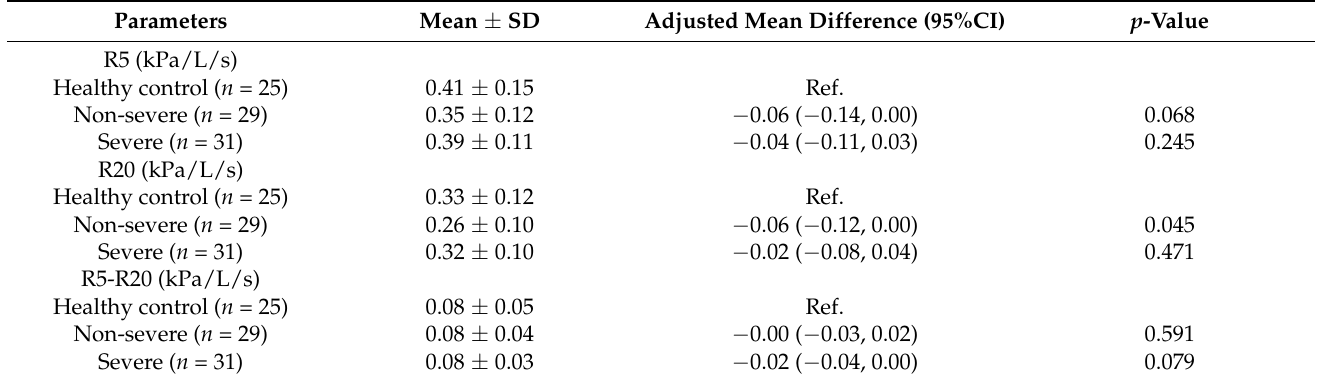
Table 7. Impulse oscillometry at one-month follow-up visit ( n =